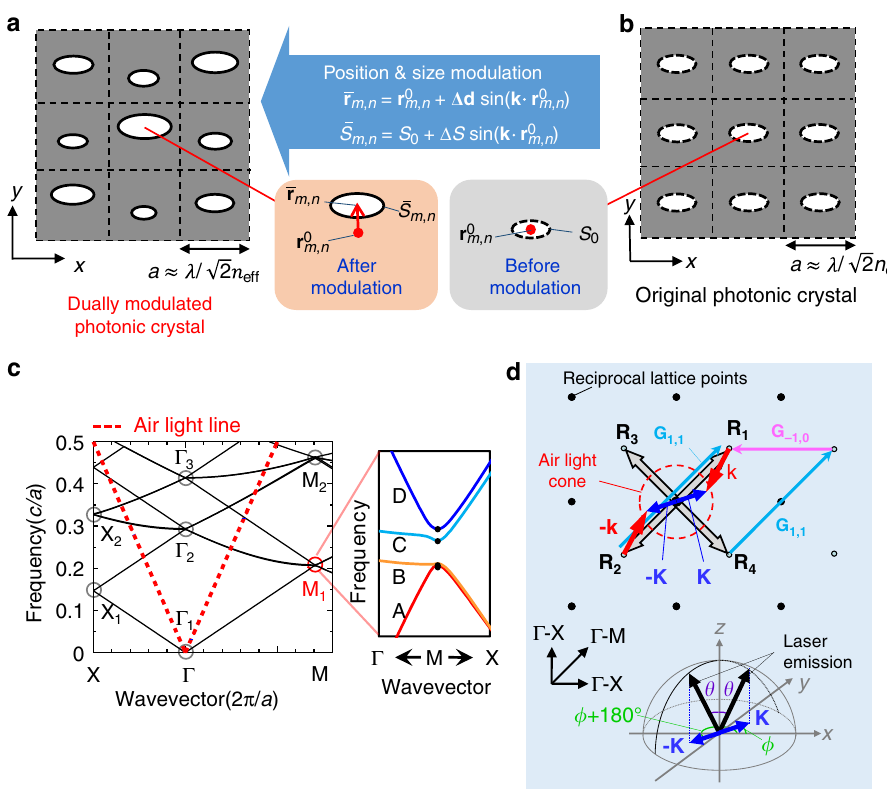
Fig. 1 Dually modulated photonic crystal for laser beam scanning. a , b Schematic diagram of dual modulation. a Dually modulated photonic crystal whose lattice-point position vectors (cid:1) r m ; n and sizes (cid:1) S m ; n have been simulateously modulated from their original values r 0 m ; n and S by amounts Δ d (cid:3) sin ð k (cid:3) r 0 m ; n Þ and 0 Δ S (cid:3) sin ð k (cid:3) r 0 Þ , respectively, where integers m and n specify the lattice point, Δ d is the position modulation vector, Δ S is the size modulation amplitude, m ; n ; R ; R and k is a diffraction vector that diffracts the four fundamental waves ( R , and R in d ) inside the air light cone. a is the photonic-crystal lattice 1 2 3 4 constant and λ is the wavelength in free space. b The original photonic crystal before modulation. c Band diagram of a square-lattice photonic crystal, and a magni fi ed view of the four band-edges A, B, C, and D at the M 1 -point, which lies below the air light line and is used for lasing. d Schematic diagram of light diffraction in reciprocal lattice space at the M 1 -point. Diffraction of the four fundamental waves ( R 1 ; R 2 ; R 3 , and R 4 ) by k leads to the generation of vector (cid:1) (cid:3) K , where K ¼ 2 π ð sin θ cos ϕ ; sin θ sin ϕ Þ with the emission direction in free space given by polar angle θ and azimuthal angle ϕ and the wavelength in free λ space given by λ . Note that both positive and negative vectors ( K and – K ) are generated because the modulation induces not only positive but also negative k vectors. Thus the emission occurs simultaneously in two directions, ( θ ; ϕ ) and ( θ ; ϕ þ 180 (cid:4) ). G 1 ; 0 and G 1 ; 1 are reciprocal lattice